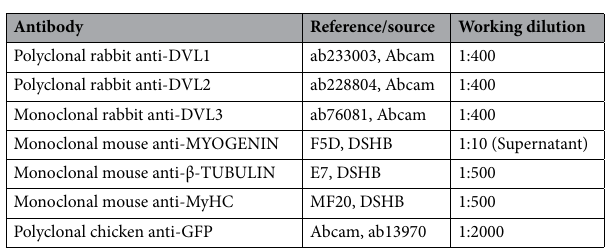
Table 2. Primary antibodies used for immunolabelling.